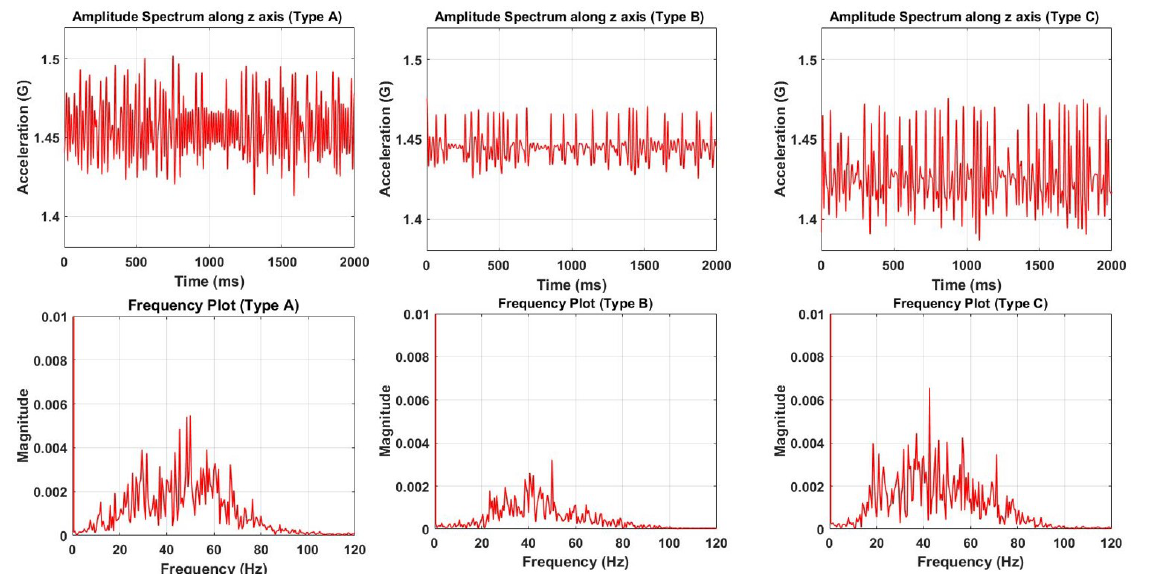
Figure 7. Rendered simultaneous pressure and vibration feedback for Type A, Type B, and Type C Surfaces in the time and single-sided frequency domain.